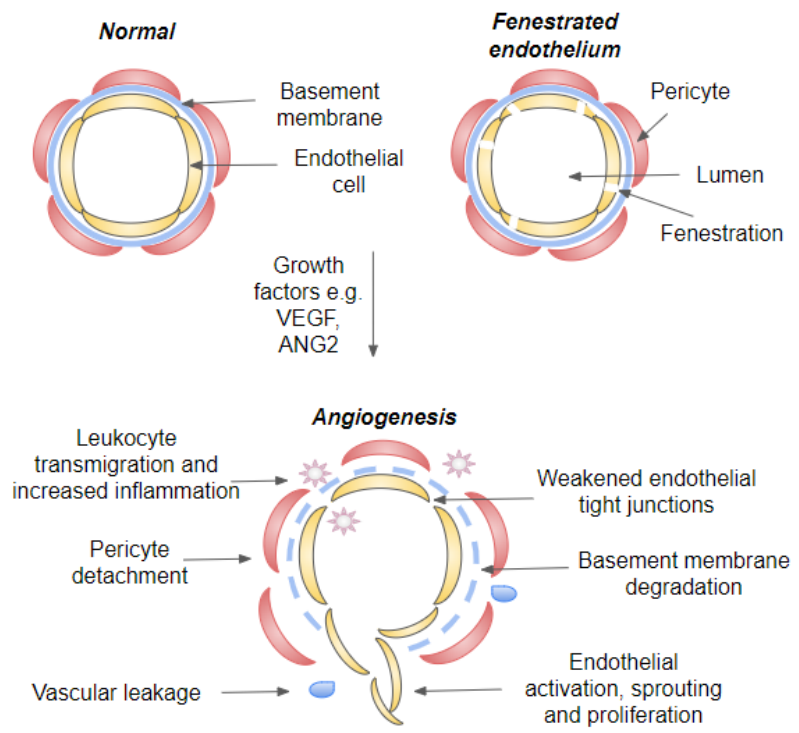
Figure 4. Illustration of a blood vessel in quiescent and angiogenic state. Cross-section of a capillary, fenestrated capillary and blood vessel during neovascularization. During vascular homeostasis, en- dothelial cells are connected by tight junctions and covered by both basement membrane and peri- cytes. Growth factors such as VEGF-A and ANG2 induce angiogenic switch that will lead to weak- ening of endothelial tight junctions, pericyte dropout and initiation of angiogenesis. Endothelial destabilization will further lead to vascular leakage and leukocyte transmigration. Abbreviations: VEGF, vascular endothelial growth factor; ANG, angiopoietin.